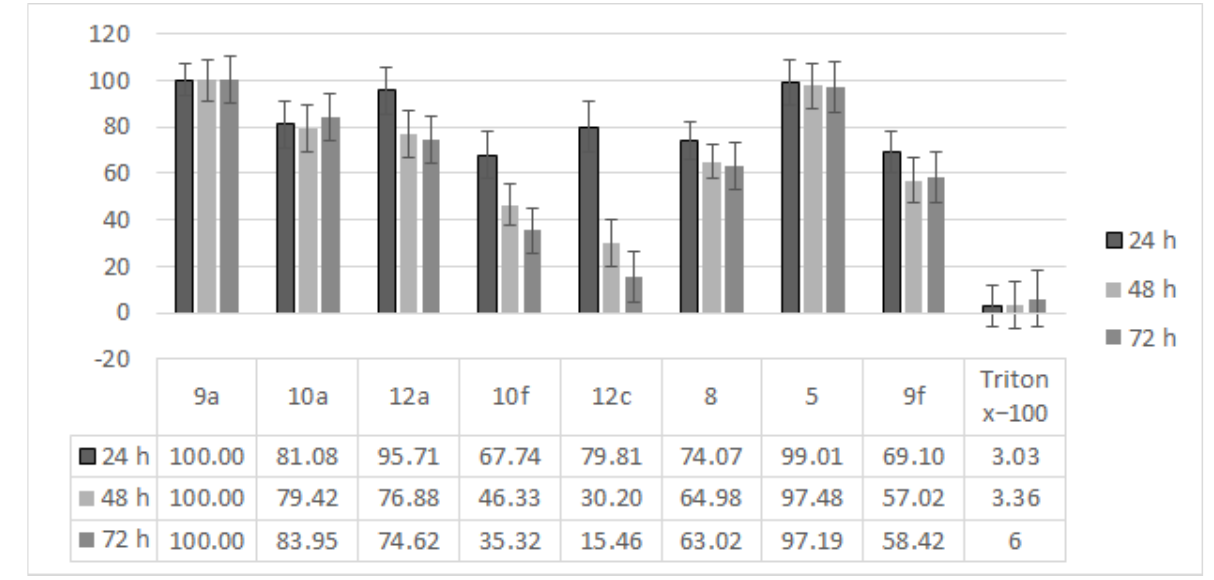
Figure 7. Cell viability (%) of normal human dermal fibroblasts (HDF) exposed to the tested com ‐ pounds at a concentration of 200 μ M assessed with the use of an MTT assay.